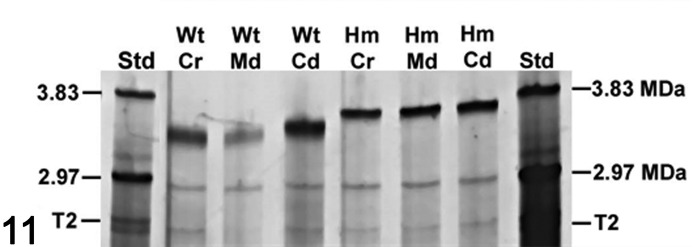
Agarose gel electrophoresis of TTN isoforms in different portions of the esophagus in
Rbm20+/+ and Rbm20–/– animals without megaesophagus. TTN isoforms are larger
in all parts of the esophagus in Rbm20–/– rats.
All esophagus samples contain a band at 2.97 MDa (the predominant TTN isoform) from the
deliberate addition of wild-type cardiac TTN for use as an internal size standard. Cd,
caudal thoracic esophagus; Cr, cervical esophagus; Hm, Rbm20–/–; Md, cranial thoracic esophagus; MDa, megadaltons;
Std, mass standard; T2, a proteolytic fragment of TTN; Wt, Rbm20+/+.